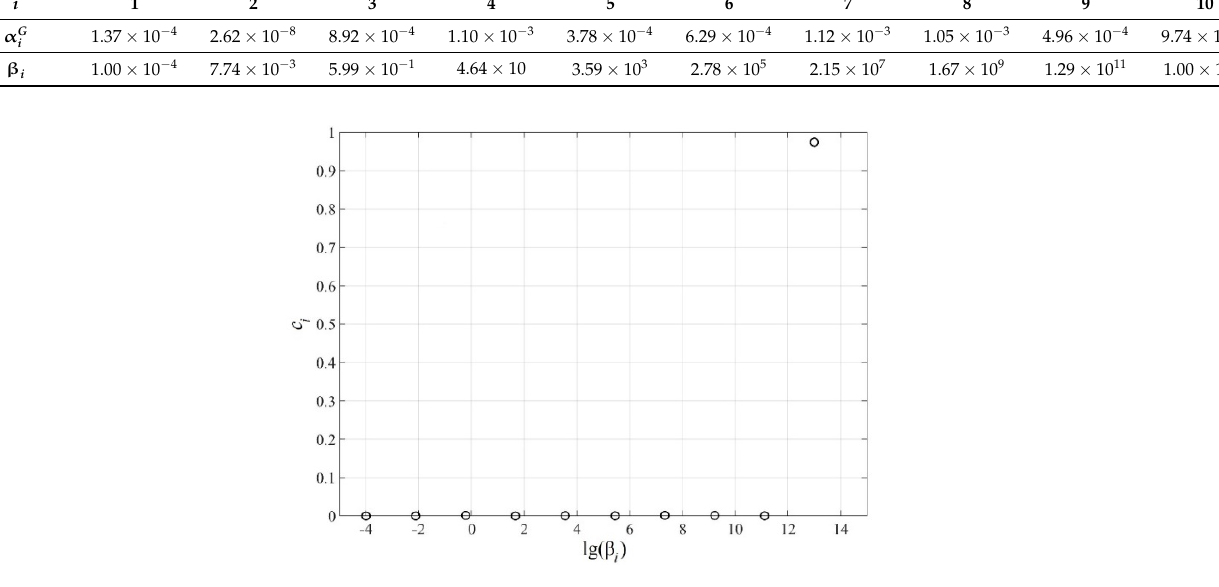
. Figure 6. Dependence of c i on β i . (cid:3036)